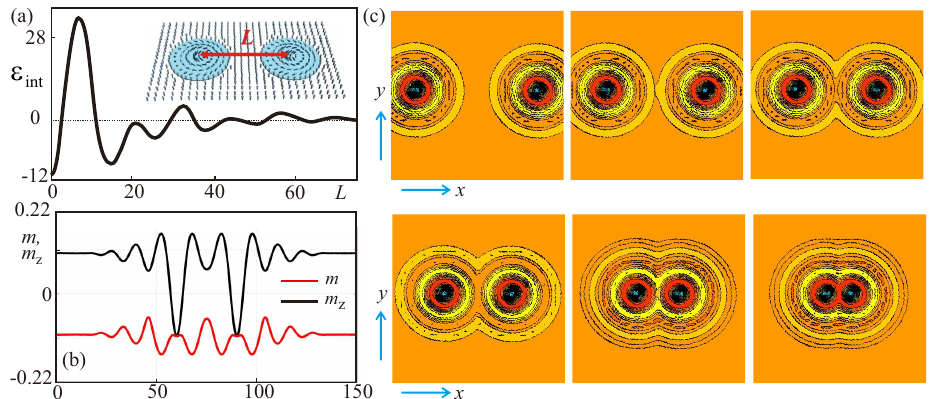
Figure 3. (color online) ( a ) The skyrmion–skyrmion interaction energy ε int plotted in dependence on the distance L between the centers of two isolated skyrmions. The energy ε int exhibits a number of local minima which imply attracting skyrmion interaction; ( b ) Dependencies of the modulus m (red line) and m z -component of the magnetization (black line) in the cross-section of two interacting isolated skyrmions for a = 0.21, h = 0.048 corresponding to the first (deepest) minimum of the interaction energy ε int ; ( c ) color plots of m z -component of the magnetization showing skyrmion pair configurations corresponding to the local minima of ε int